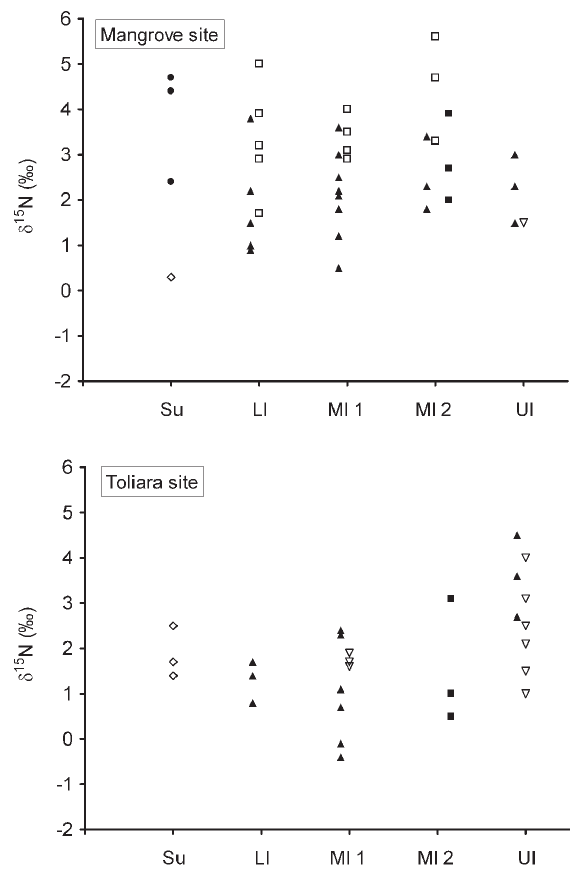
) and c/n ratios (w:w) of seagrass collected on the Great dw reef of toliara.